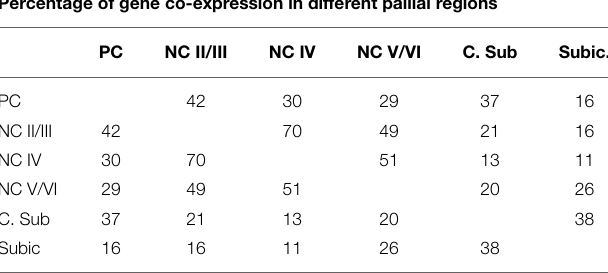
TABLE 1 | Percentage of shared genes among the first 500 genes enriched in each of the indicated pallial sub-regions. Percentage of gene co-expression in different pallial